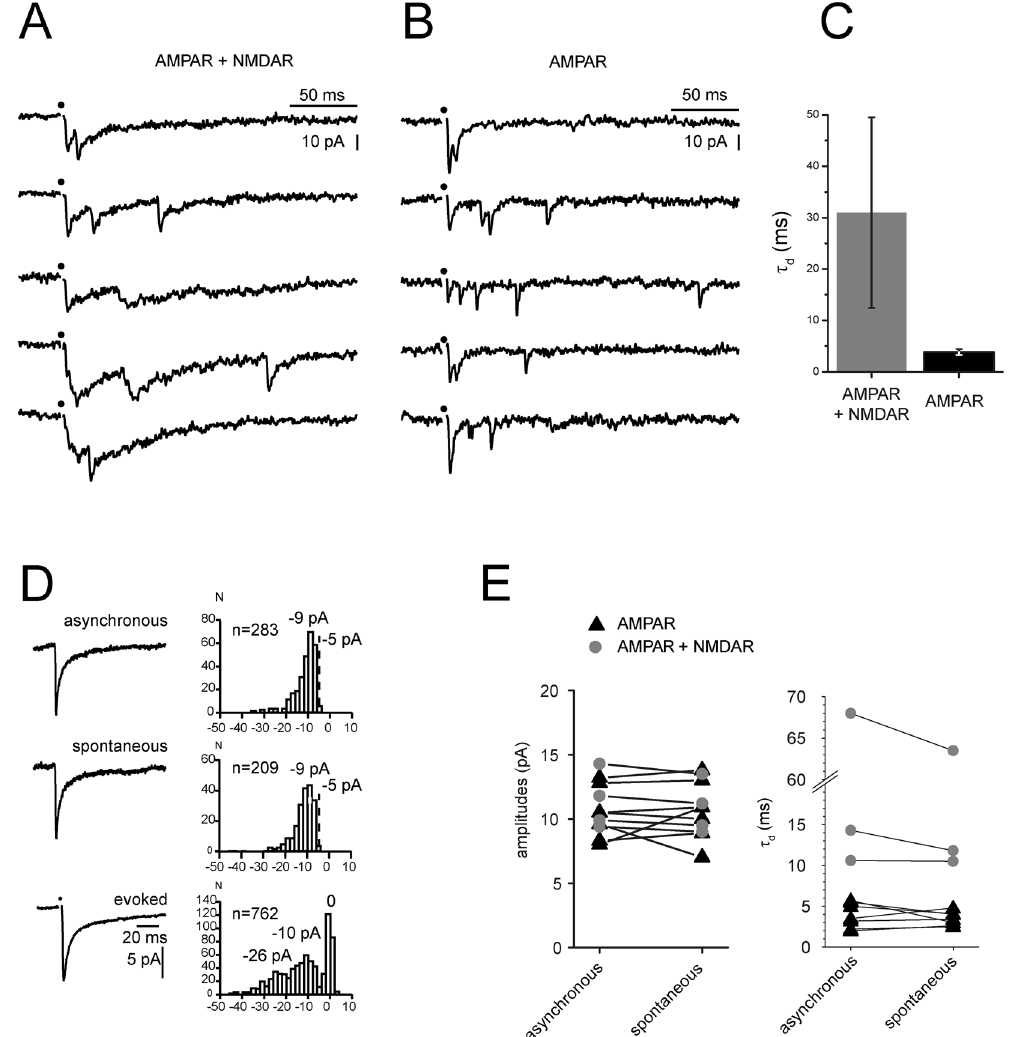
Figure 6. Asynchronous glutamatergic EPSCs (aEPSCs) resemble spontaneous and miniature glutamatergic EPSCs. All data were obtained at − 60 mV in solutions containing Sr 2 + (8 mM), Mg 2 + (1 mM), no Ca 2 + and blockers of GABA A Rs, GlyRs and nAChRs. ( A , B ) VR stimulation with a near threshold intensity elicited an evoked EPSC (eEPSC) followed by aEPSCs. Each column illustrates five records from the same cell. In A , neither AMPARs nor NMDARs were blocked. ( B ) As in A, but after addition of D-APV. ( C ) Comparison of the decay time constants of the fast rising aEPSCs (with a rise time of less than 1 ms) before and after addition of D-APV. In the two-receptor condition, most of the fast rising aEPSCs had a slow decay, which was shortened after addition of D-APV. ( D ) Comparison of the aEPSCs, sEPSCs and eEPSCs evoked by minimal stimulation in the same cell. Neither AMPARs nor NMDARs were blocked. The histograms of aEPSCs and sEPSCs amplitudes have a single peak, the value of which matches that of the main peak in the eEPSC amplitude histogram. ( E ) Comparison of the amplitudes and of the decay time constants of aEPSCs and sEPSCs recorded in the absence and presence of